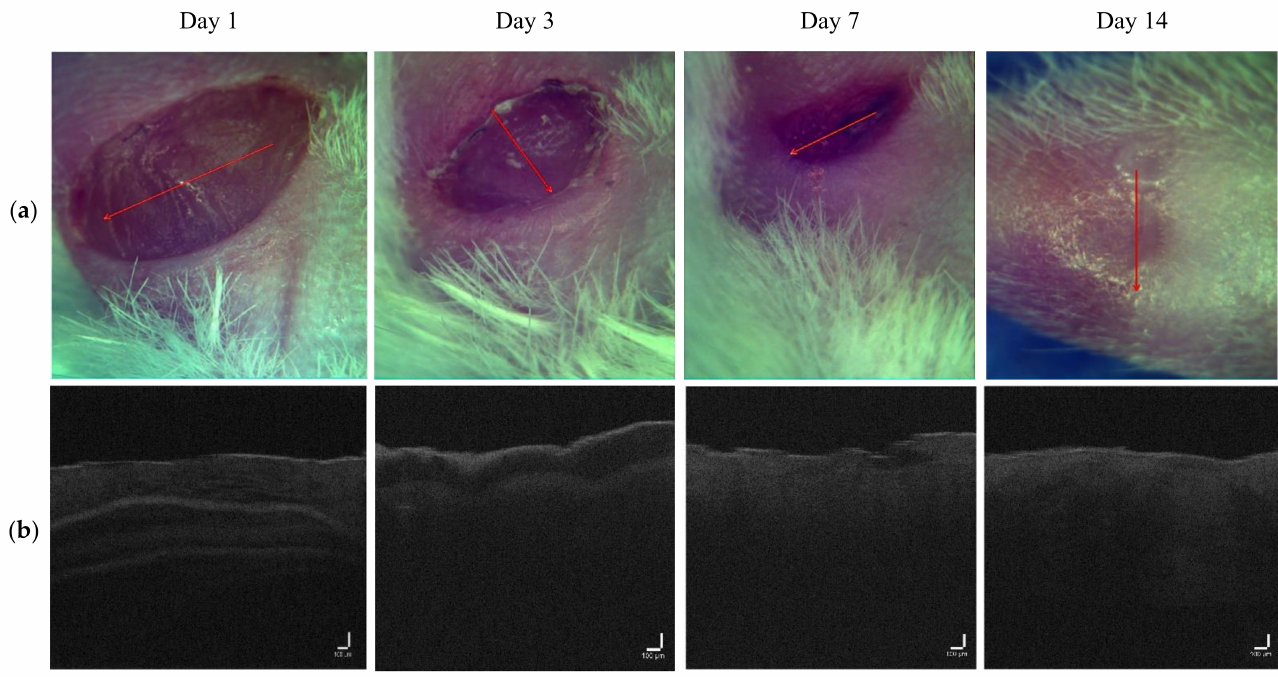
Figure 8. ( a ) Visual observation and ( b ) the corresponding B-scans for the LDPDT-5-ALA 4 J/cm 2